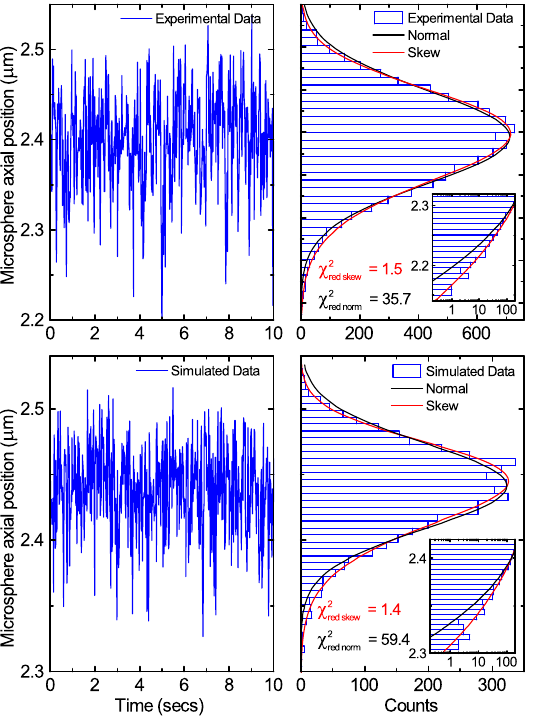
Figure 3. Representative examples of experimental and simulated bead height fluctuations. Top row: Representative example of experimental bead height fluctuations for the 7 : 3 kb construct at a measured force of 0 : 45 pN . The time trace on the left is a 10 s sample of the 300 s measurement. Bottom row: Simulated data for a tether with L C ~ 7 : 3 kb 2 : 475 m m ð Þ at a measured force of 0 : 46 pN . The time trace on the left is a 10 s sample of the 100 s simulation. Plotting both experimental and simulated data as histograms it becomes clear from the reduced chi squared values that a skew normal distribution is a much better fit than the normal distribution to describe the microsphere axial position fluctuations. The difference between the arithmetic mean, m z , of the microsphere axial position and the skew normal distribution location, j z , is 43 + 2 nm and 29 + 2 nm for the experimental and simulated data respectively. The inset log-linear zooms display the same data and more clearly show the large discrepancy of the data from a normal distribution, indicating that the skew normal distribution is a much better